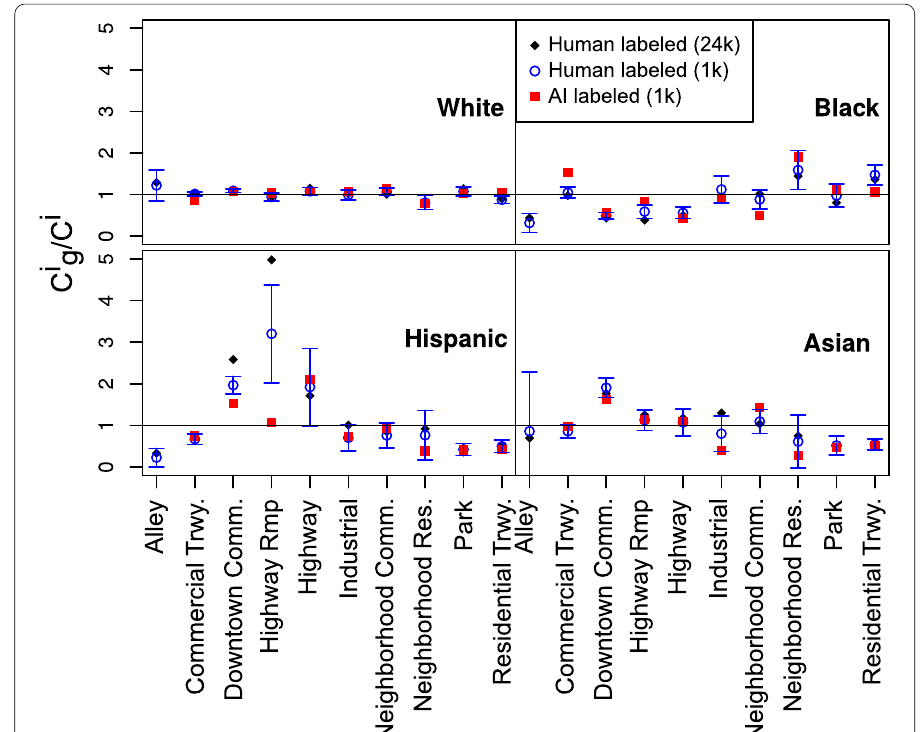
Fig. 4 Relation between average fraction of street context per group C i g and general average fraction of street context C i using set H ( ∼ 24,000 human labeled images). White group has values similar to the average, as they are the principal group of the city. Non-White groups have a low fraction of Park context. Blacks have a high fraction of Residential contexts. Both Hispanics and Asians have high fraction of Downtown Commercial contexts. Hispanics have a very high context of Highways. The result obtained using set A P ( ∼ 1000 AI labeled images) is similar in average to the one using sub-samples of H (samples of ∼ 1000 human labeled images), taking into account the error